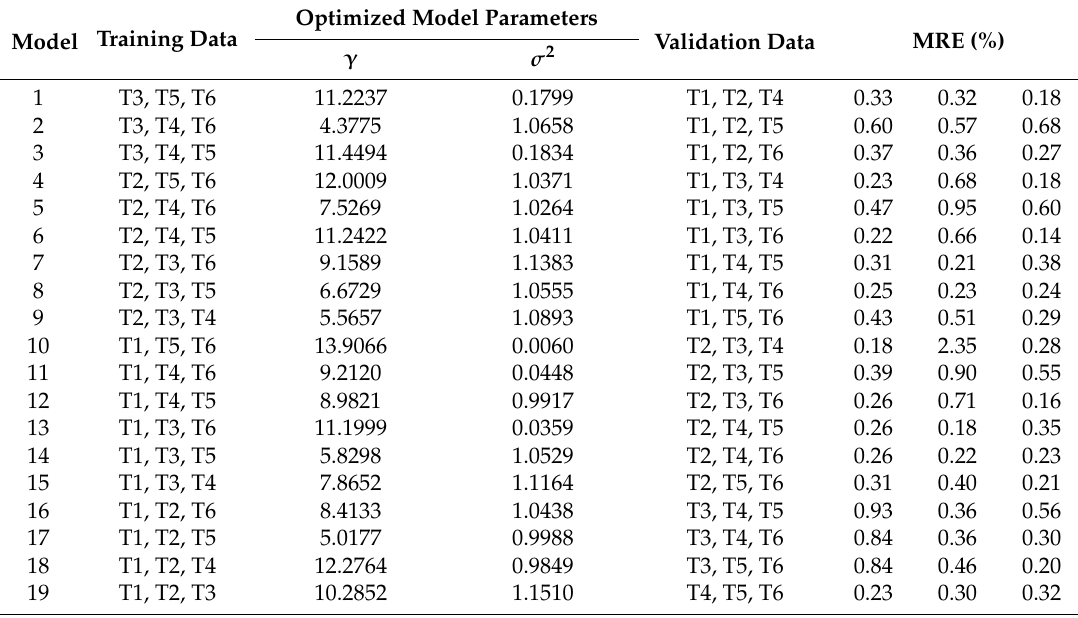
Table 6. The optimized parameters for different training data and the prediction results.